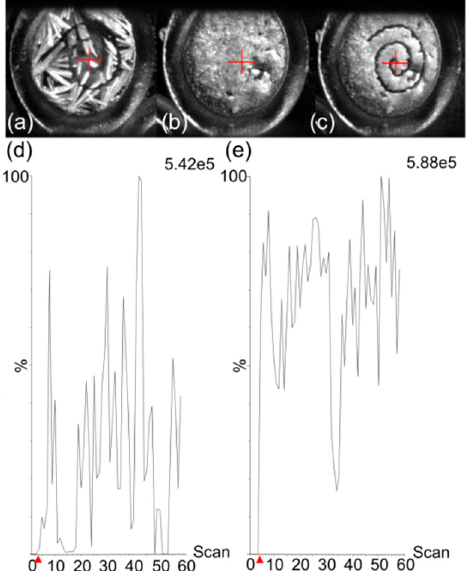
Figure 2. ( a ) Morphology of a sample with 2,5-dihydroxybenzoic acid (2,5-DHB) deposited after the deposition of a liquid–liquid extraction (LLE) extract, after analysis. Morphology of a sample after the deposition of a LLE extract on metal target pre-spotted with 2,5-DHB ( b ) before and ( c ) after analysis. ( d ) Total ion current (TIC) from sample ( a ). ( e ) TIC from sample ( c ). The maximum intensities are given in arbitrary units at the top right of each TIC. Red arrows on the x-axis correspond to the time of laser